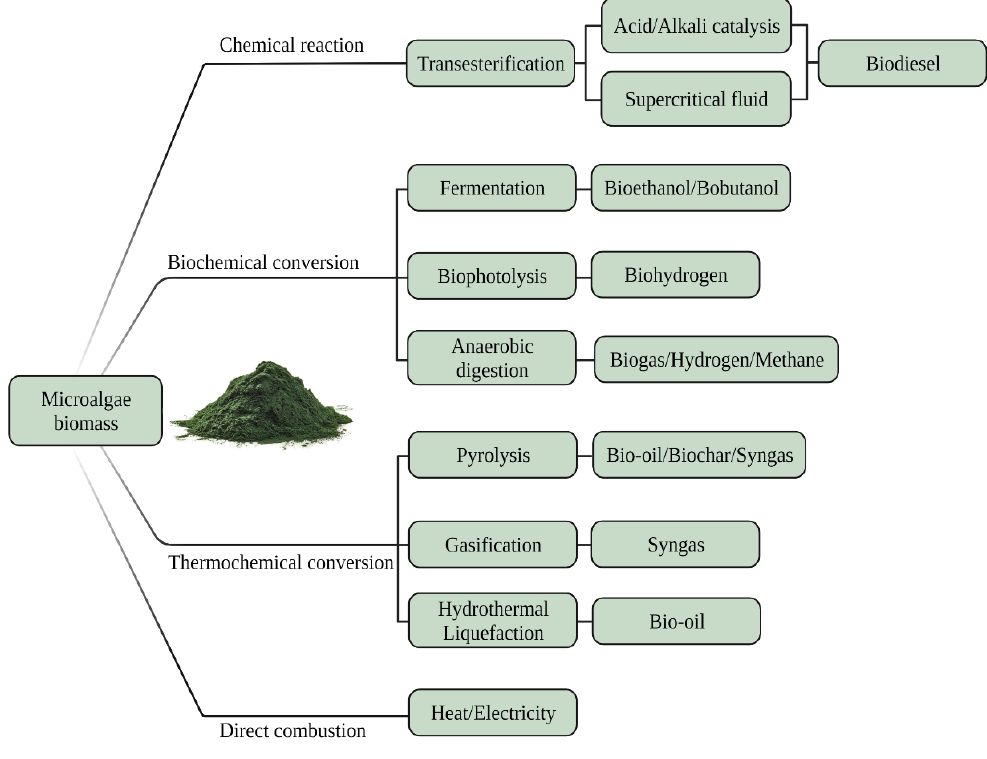
Figure 3. Bioenergy production based on the biomass from microalgal consortia. Table 6. Microalgal consortia for biofuel production.